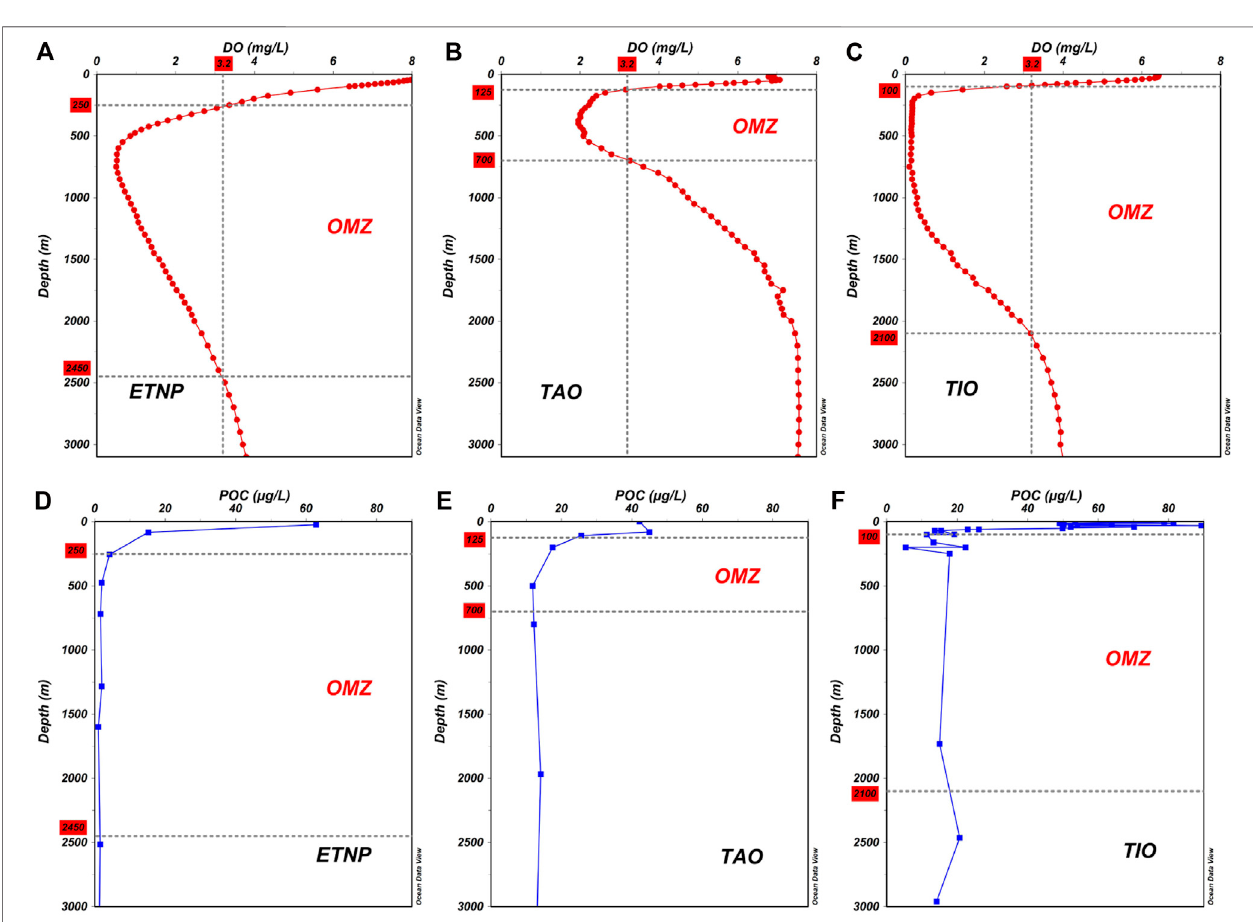
FIGURE5| VerticaldistributionofDO andPOC indifferentareas. (A) TheannualaverageDO intheEasternTropicalNorthPaci fi c(ETNP).TheOMZwaslocated in thewatercolumnof250 – 2,450 mbasedontheDOthresholdof3.20 mg/L. (B) TheannualaverageDOintheTropicalAtlanticOcean(TAO).TheOMZwaslocatedinthe water column of 125 – 700 m. (C) The annual average DO in the Tropical Indian Ocean (TIO). The OMZ was located in the water column of 100 – 2,100 m. All the annual average DO data were downloaded from the World Ocean Atlas 2018. (D) The vertical distribution of POC in the ETNP. (E) The vertical distribution of POC in the TAO. (F) The vertical distribution of POC in the TIO. All the POC data were cited from (Martiny et al., 2014).